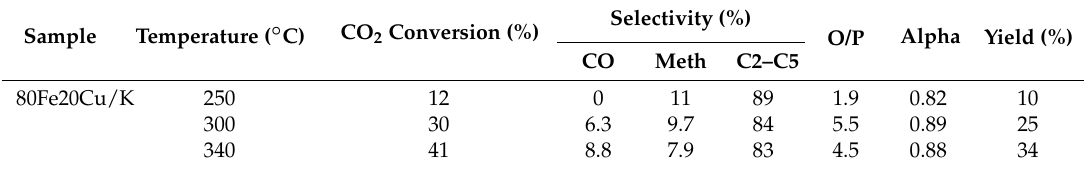
Table 4. Relationship between temperature and activity for